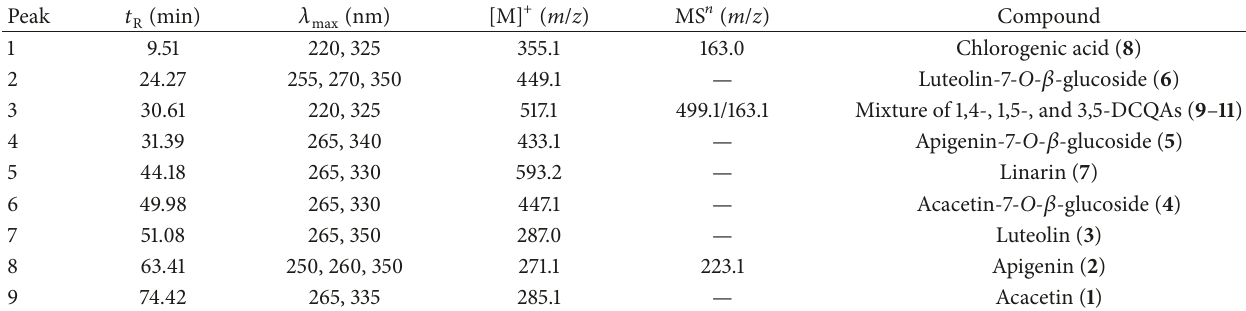
Table 2: Identification and mass spectrometric properties of the phenolic compounds from chrysanthemum cultivars. Peak